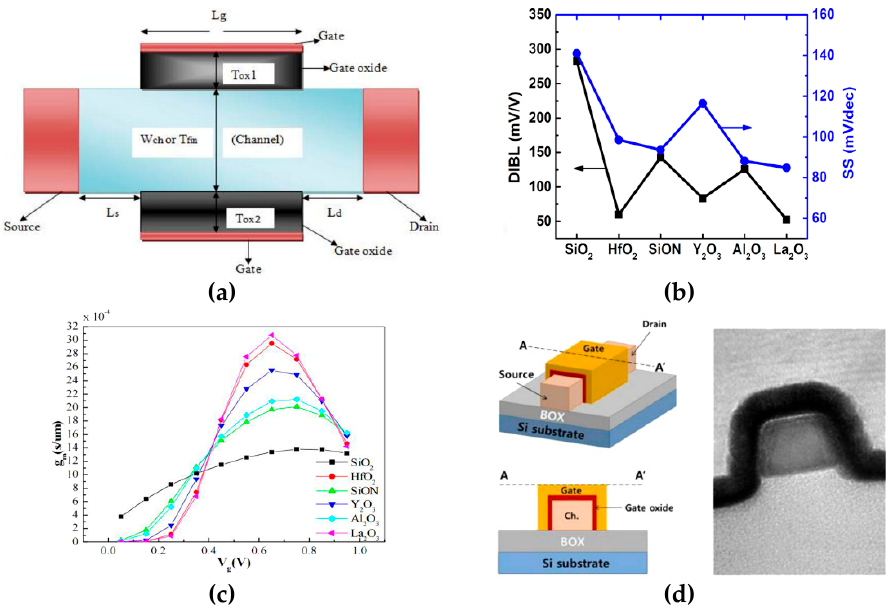
Figure 17. ( a ) Device structure, ( b ) DIBL and SS characteristics, and ( c ) g m of DG FinFET’s with different gate dielectrics [148,149]. ( d ) Device structure of TG FinFET [150].